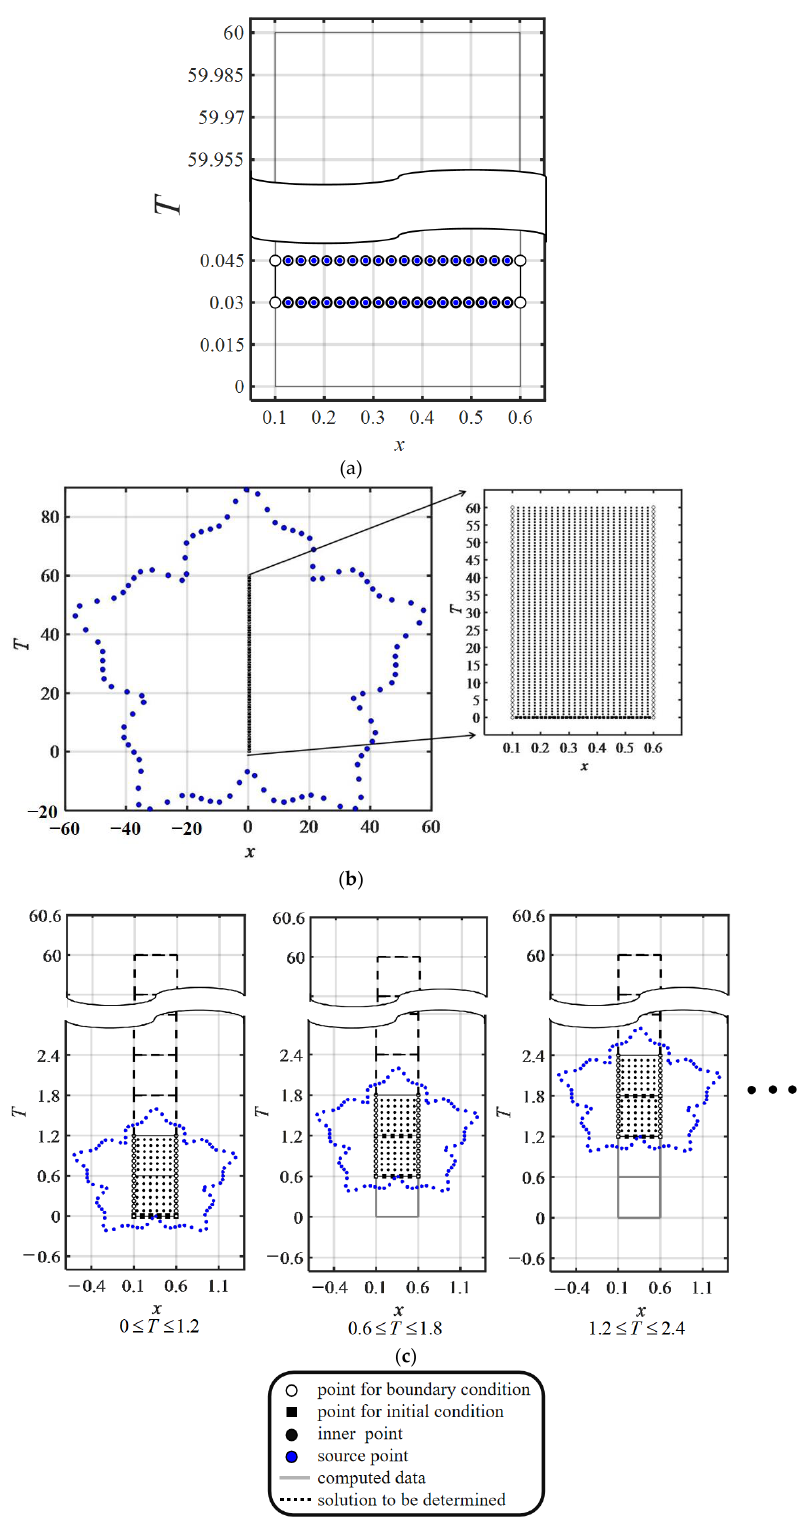
with a time step of 1.5 × 10 −2 .